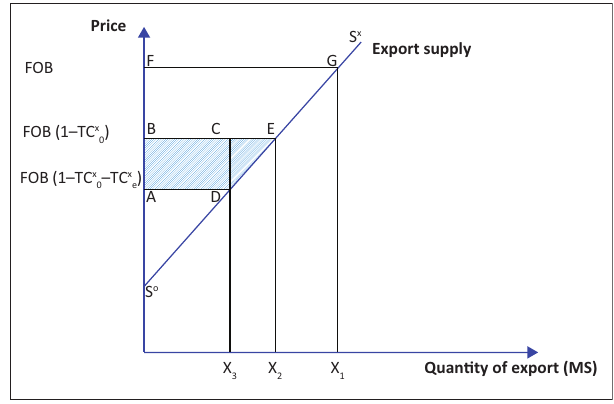
FIGURE 2: Economic impact of export compliance